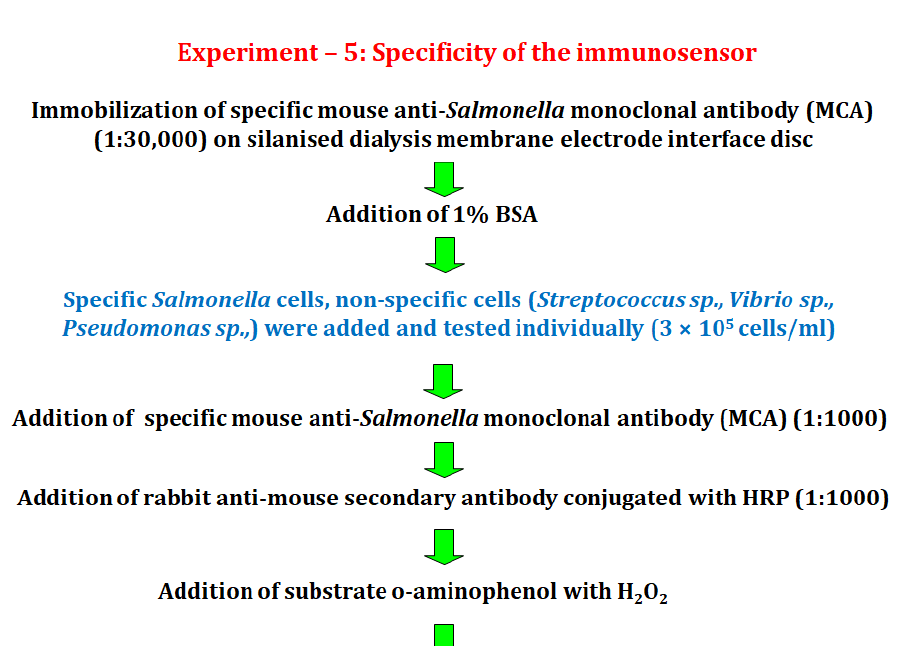
Figure 6. Diagram showing the processes for specific detection of Salmonella cells.